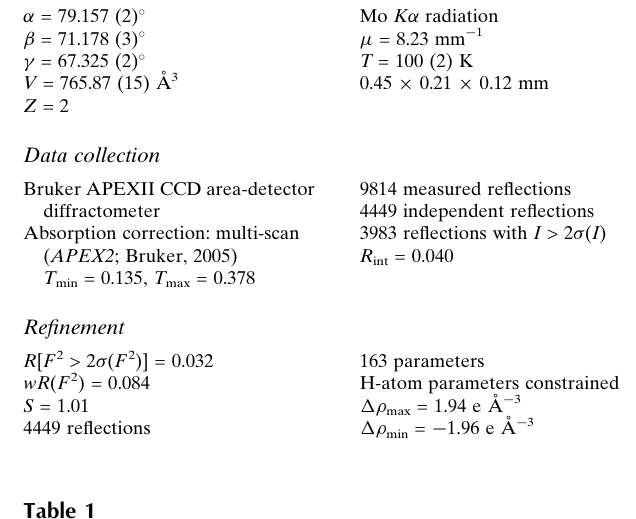
Selected geometric parameters (A˚ , (cid:1)